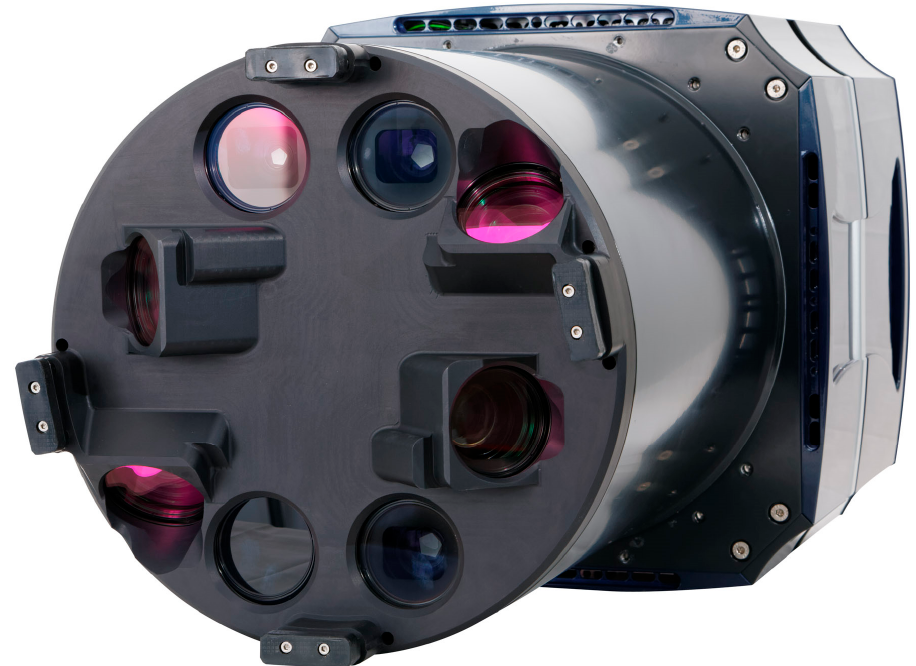
Figure 5. The Microsoft/Vexcel UltraCam Osprey Prime II for combined nadir and oblique image capture. Image source: https://ultracam.files.wordpress.com/2014/04/ucop_2.png.